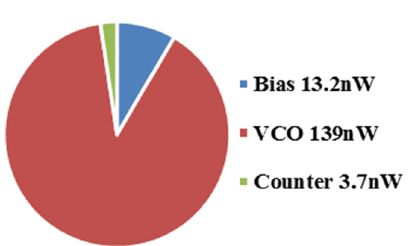
Figure 8. Layout.